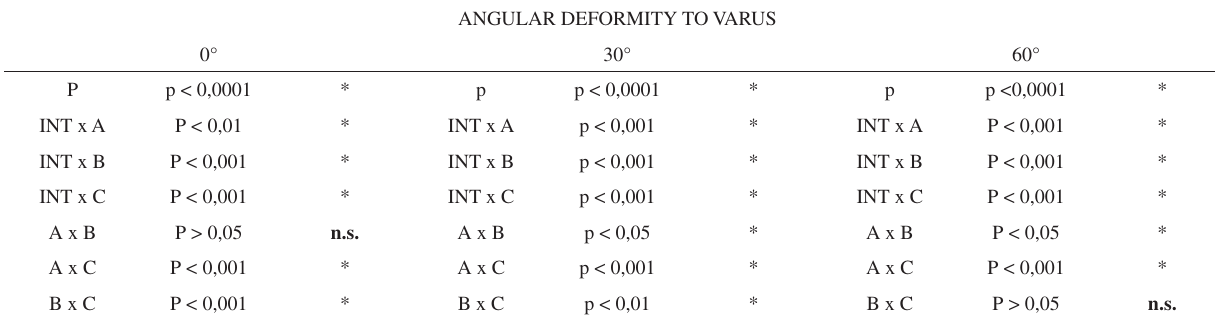
Table 3 - Comparative table and p values for the situations in varus testing to angular deformity. ANGULAR DEFORMITY TO VARUS